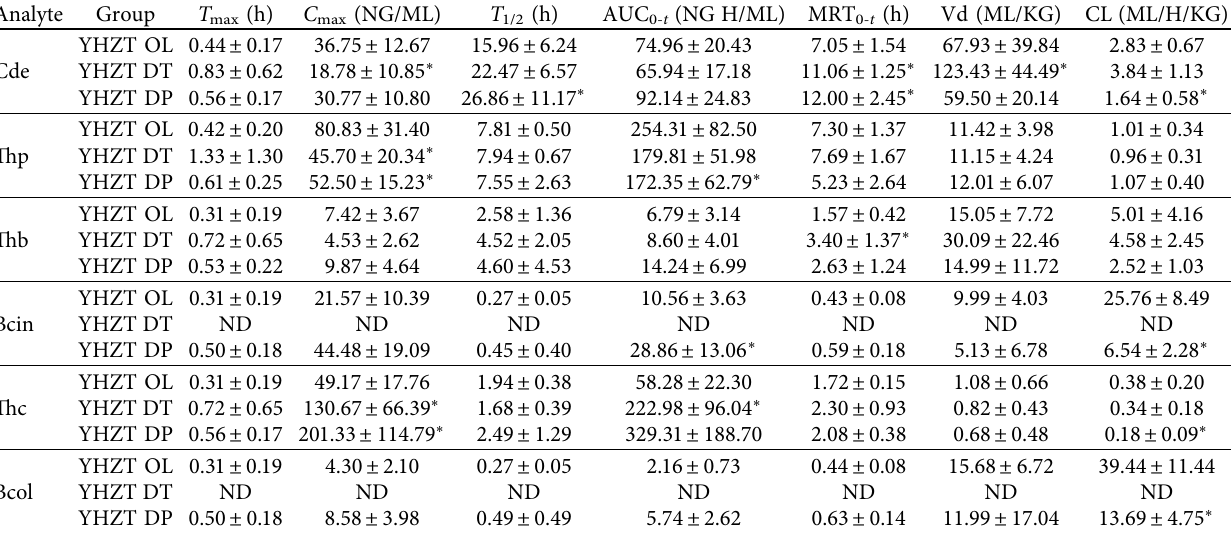
Table 8: PK parameters of the six analytes after oral administration of YHZT OL, YHZT DT, and YHZT DP (mean ± SD, n � 6). Analyte